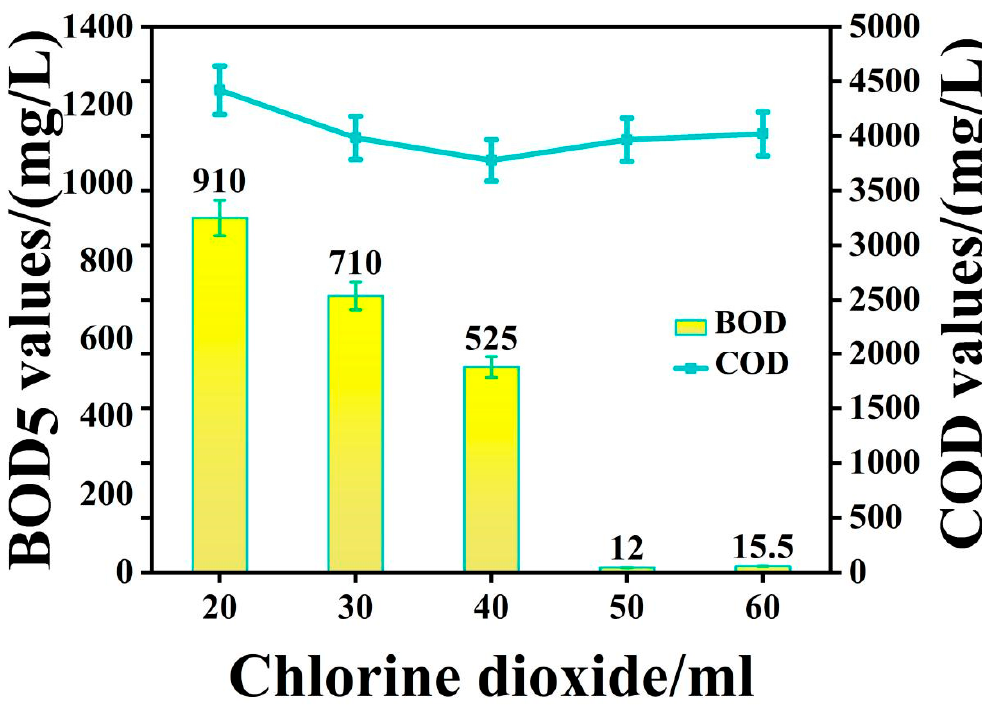
Figure 3. The BOD 5 /COD values after chlorine dioxide pretreatment.